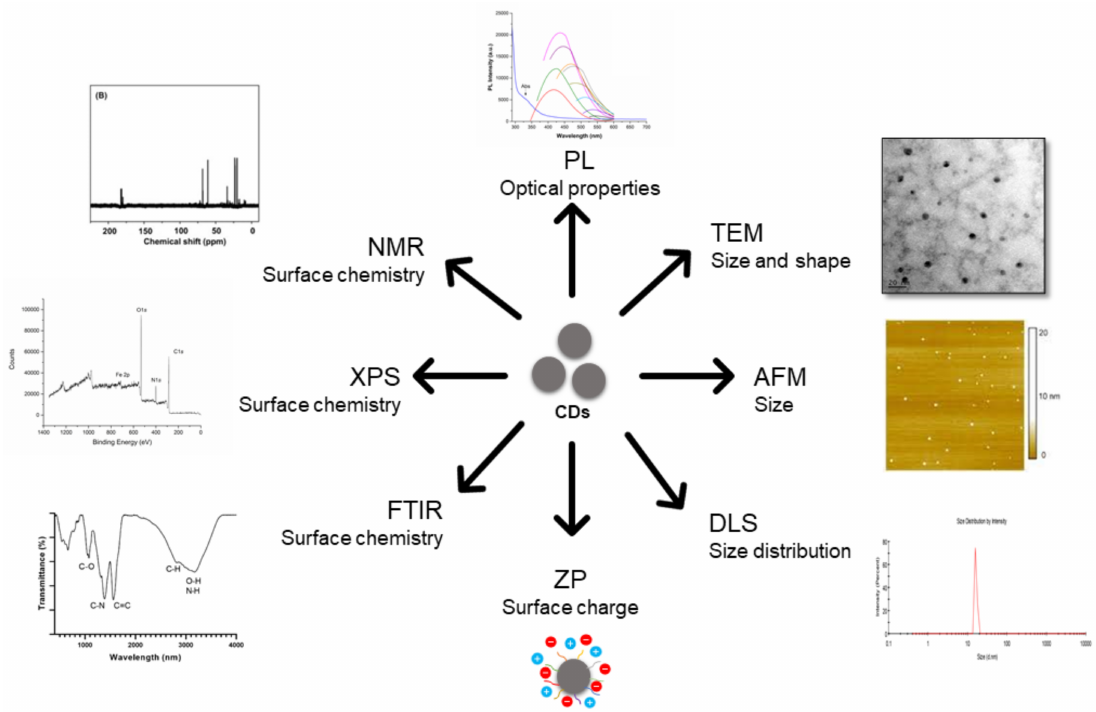
Figure 5. Physicochemical techniques employed for the characterisation of carbon